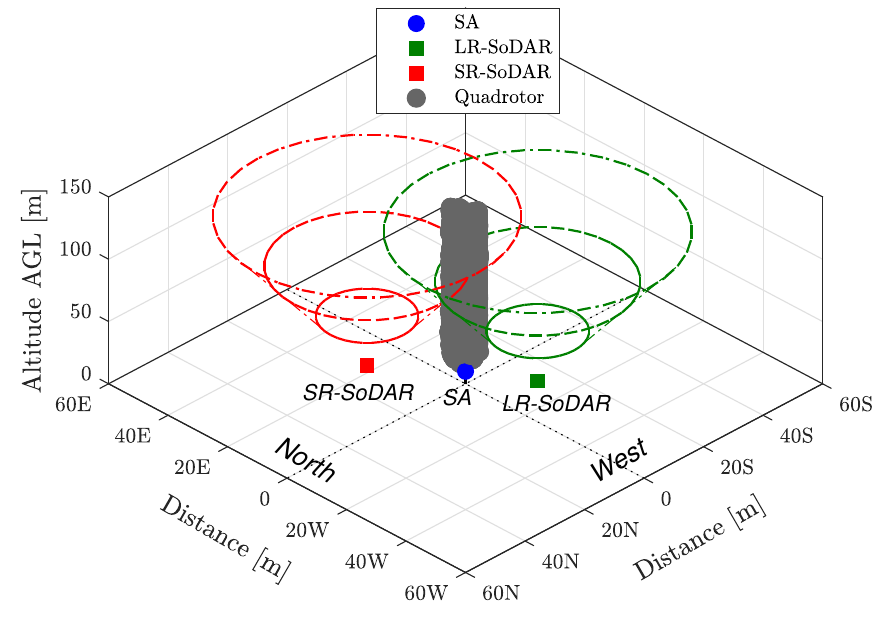
Figure A1. Spatial footprint of quadrotor operations relative to ground-based atmospheric sensors.